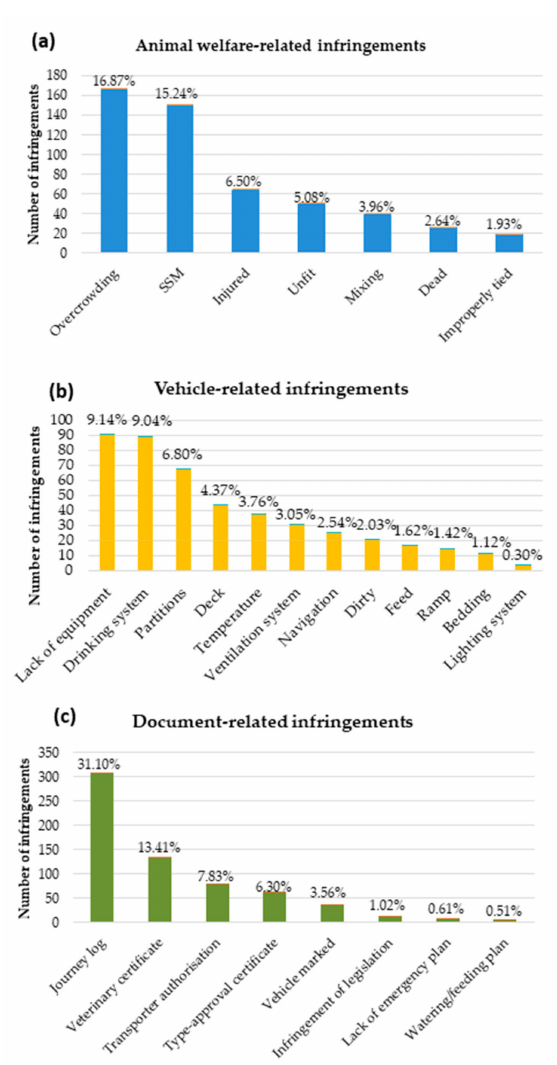
Figure 1. Subcategories of infringements that are related to animal welfare ( a ), vehicle ( b ) and documents ( c ). SSM: scheduled stop